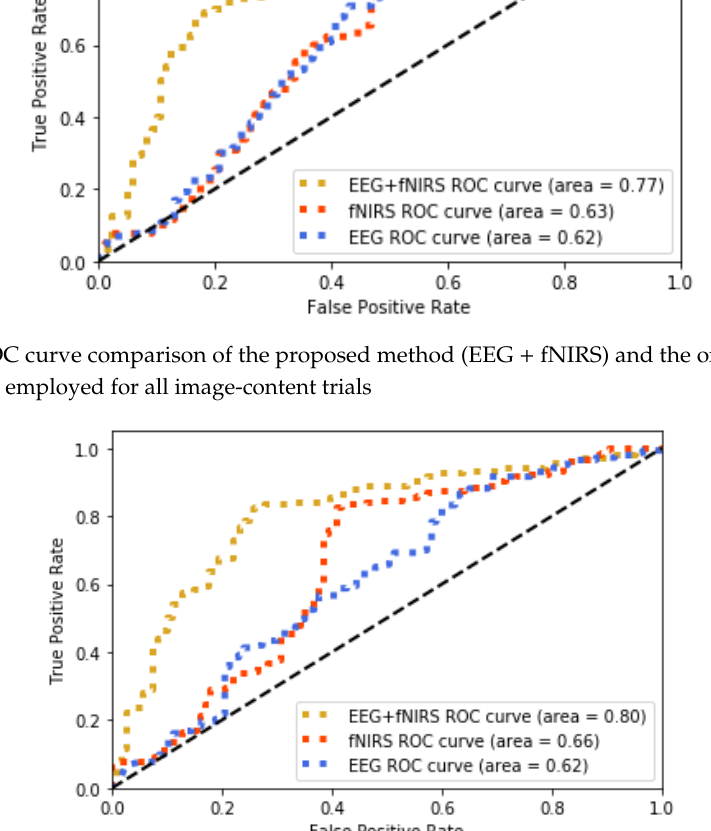
Figure 15. ROC curve comparison of the proposed method (EEG + fNIRS) and the ones where only